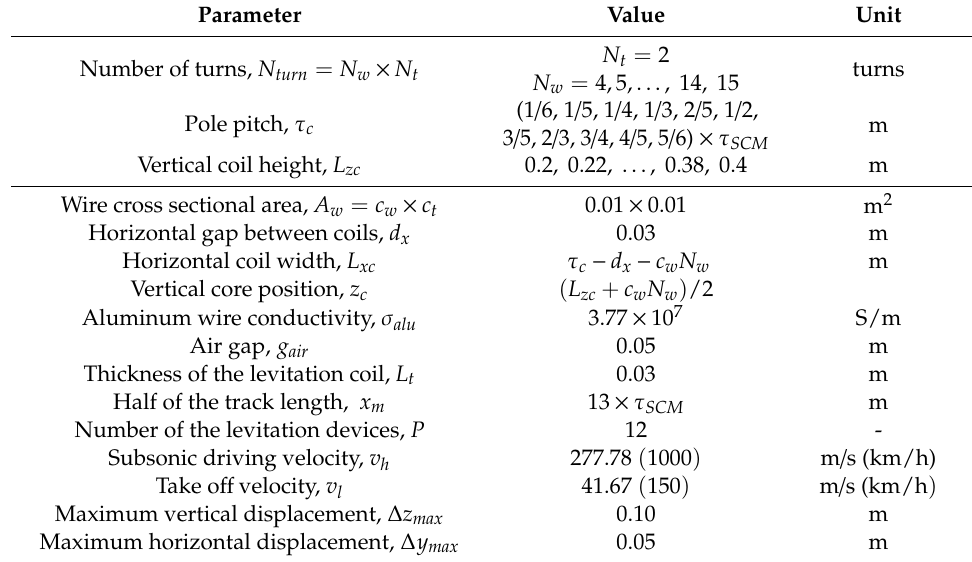
Table 1. Design parameters of the null-flux EDS device for the small-scale Hyperloop